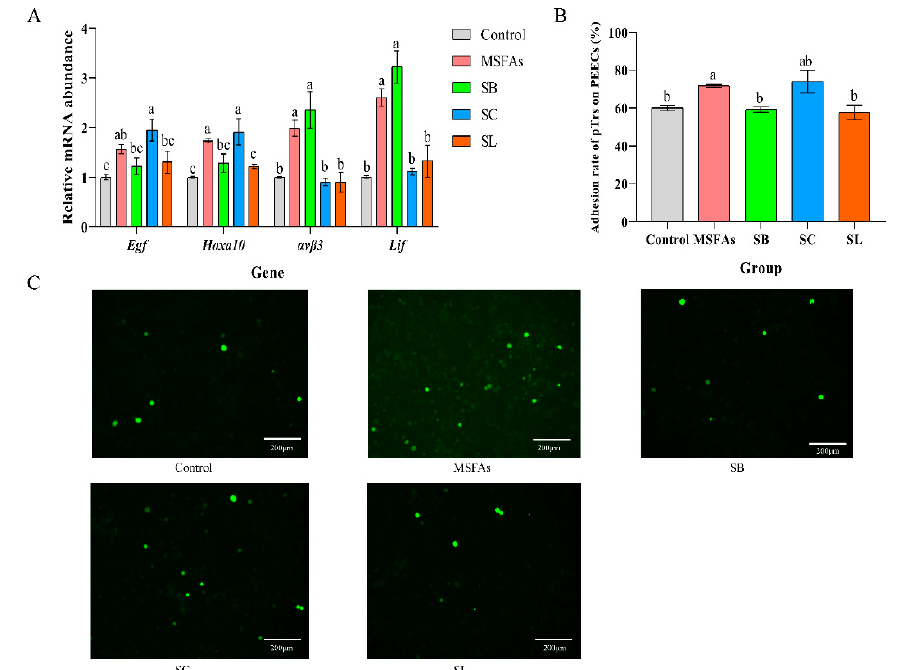
Figure 2. The combination of MSFAs can improve the receptivity of pig endometrial cells. ( A ) The relative mRNA abundance in porcine endometrial epithelial cells treated with 1 mM SB, 0.4 mM SC, 0.01 mM SL or their combination for 24 h. ( B ) Adhesion rate of porcine trophoblast cells to porcine endometrial epithelial cells treated with 1 mM SB, 0.4 mM SC, 0.01 mM SL or their combination for 24 h. ( C ) Image of adhesion of porcine trophoblast cells to porcine endometrial epithelial cells treated with 1 mM SB, 0.4 mM SC, 0.01 mM SL or their combination for 24 h observed under fluorescence microscope. The results are presented as the means ± SEM. n = 9. Different letters between bars indicate p ≤ 0.05 by one-way ANOVA followed by post hoc Tukey’s tests. ns, nonsignificant ( p > 0.05). SB, sodium butyrate; SC, sodium caprylate; SL, sodium laurate; MSFAs, SB + SC + SL.